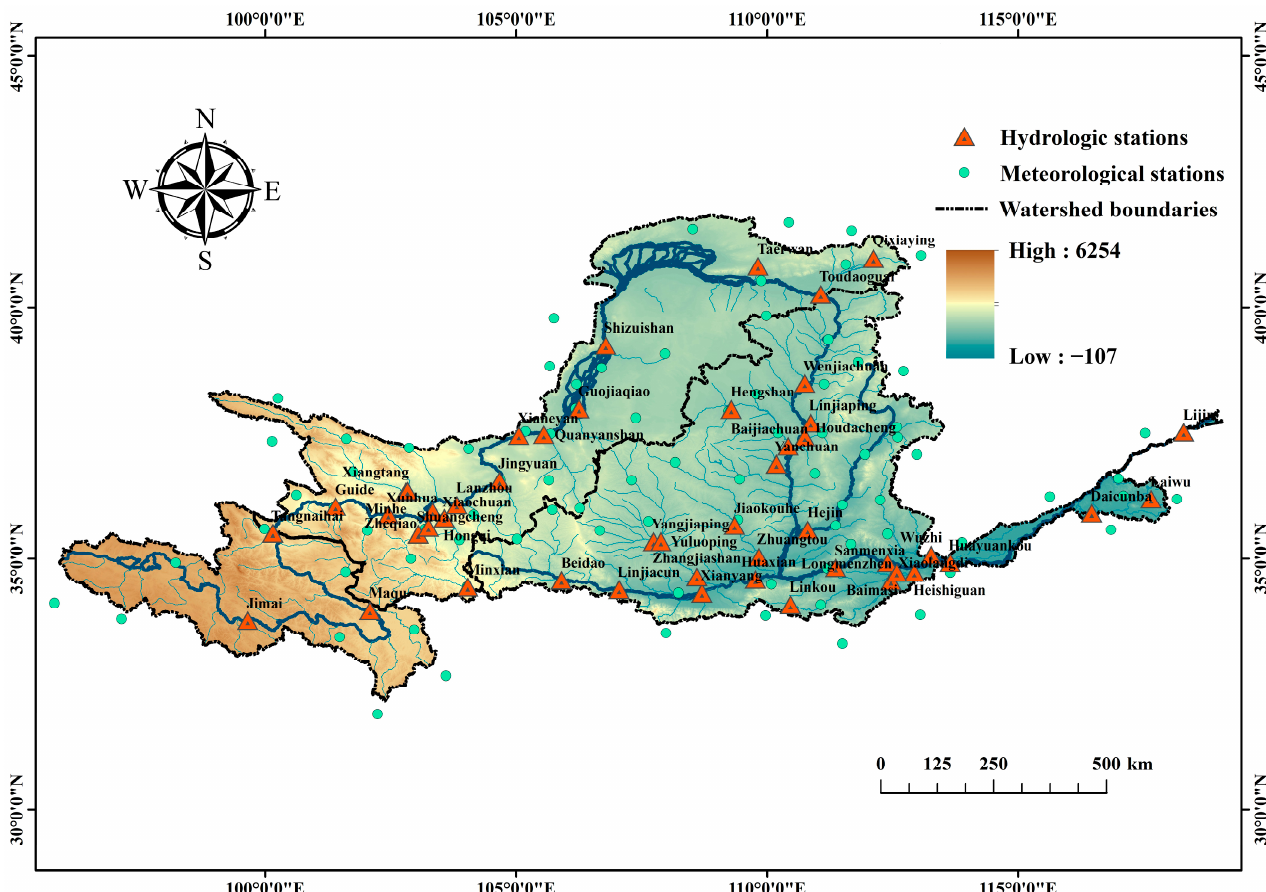
Figure 1. The location of hydrological and meteorological stations in the Yellow River Basin and sub ‐ basins.